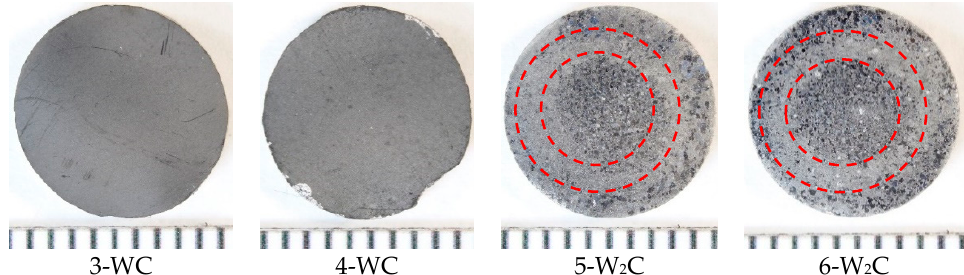
Figure 1. The appearance of tungsten samples after carbidization